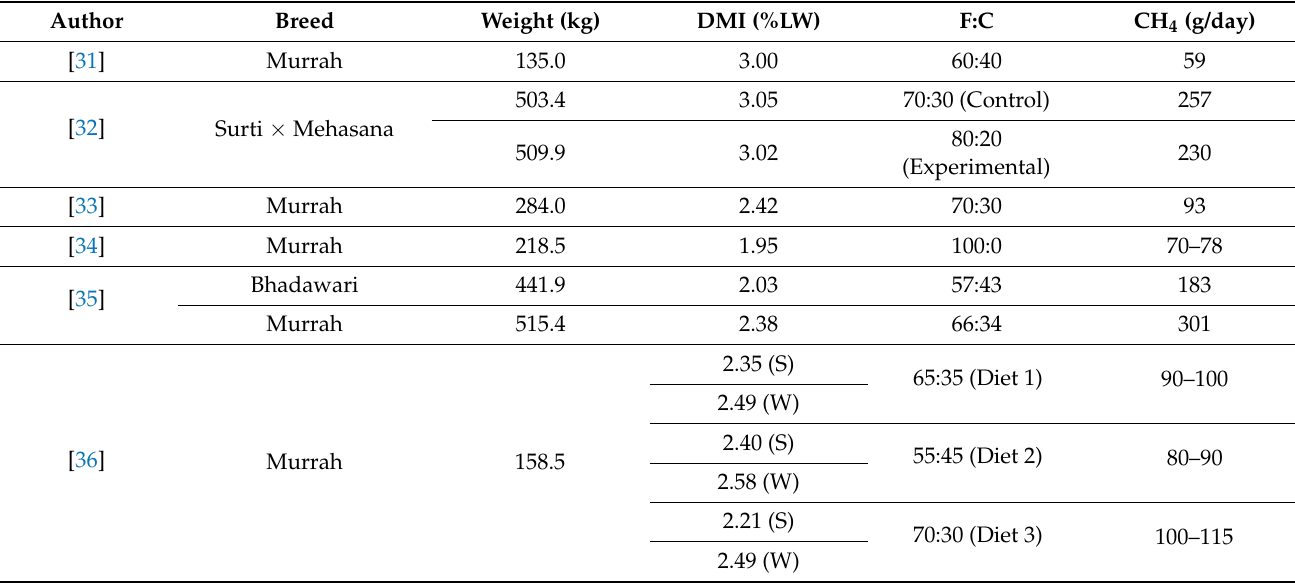
Table 4. Studies on direct CH 4 emissions measured with sulphur hexafluoride (SF 6 ) tracer technique on